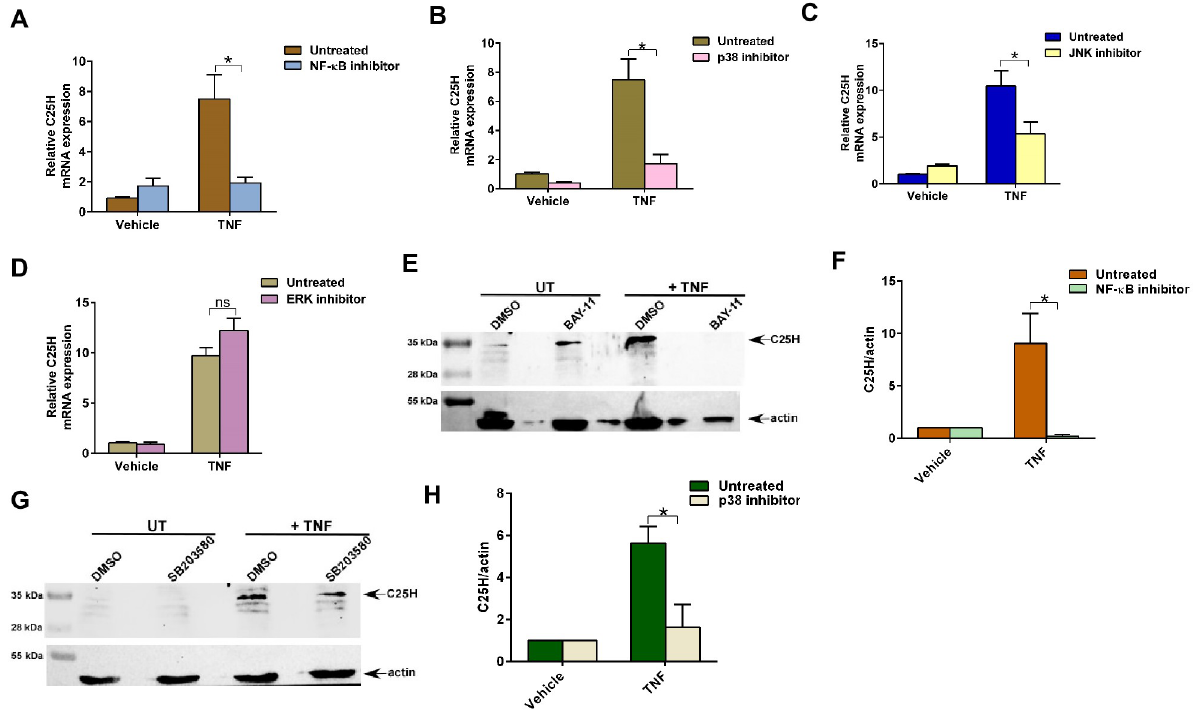
Fig 6. MAPK and NF κ B pathways are required for TNF-mediated C25H expression. (A) MEFs treated with TNF (10ng/ml) for 4h in the absence or presence of NF κ B inhibitor Bay-11 (10 μ M) were analyzed for C25H mRNA expression by RT-qPCR (n = 5–6; two independent experiments). (B) MEFs treated with TNF (10ng/ml) for 4h in the absence or presence of p38 inhibitor SB203580 (10 μ M) were analyzed for C25H mRNA expression by RT-qPCR (n = 5–6; two independent experiments). (C) MEFs treated with TNF (10ng/ml) for 4h in the absence or presence of JNK inhibitor SP600125 (25 μ M) were analyzed for C25H mRNA expression by RT-qPCR (n = 5–6; two independent experiments). (D) MEFs treated with TNF (10ng/ml) for 4h in the absence or presence of ERK inhibitor PD98059 (25 μ M) were analyzed for C25H mRNA expression by RT-qPCR (n = 5–6; two independent experiments). (E) MEFs treated with TNF (10ng/ml) for 8h in the absence or presence of NF κ B inhibitor Bay-11 (10 μ M) were analyzed for C25H protein expression by western blotting. (F) Densitometry analysis of C25H protein levels relative to actin (C25H/actin) in MEFs treated with TNF for 8h in the absence or presence of NF κ B inhibitor Bay-11 (10 μ M). C25H/actin ratio levels were normalized to vehicle treated cells. G) MEFs treated with TNF (10ng/ml) for 8h in the absence or presence of p38 inhibitor SB203580 (10 μ M) were analyzed for C25H protein expression by western blotting. (H) Densitometry analysis of C25H protein levels relative to actin (C25H/actin) in MEFs treated with TNF for 8h in the absence or presence of p38 inhibitor SB203580 (10 μ M). C25H/actin ratio levels were normalized to vehicle treated cells. RT-qPCR data are shown as Mean ± SEM by using one-way ANOVA multiple comparison test. � p � 0.05. ns; not significant. Immunoblot images are representative from three independent experiments. The densitometric values represent the mean ± SEM from three independent experiments. � p < 0.05 determined by Student’s